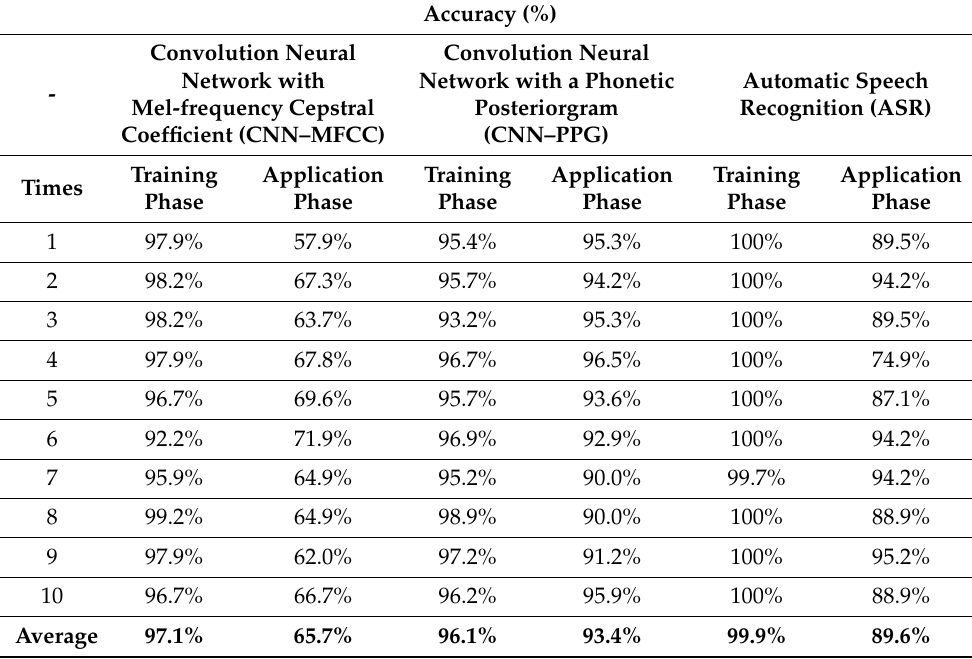
Table 1. Results of the 10 repeated experiments for each of the three